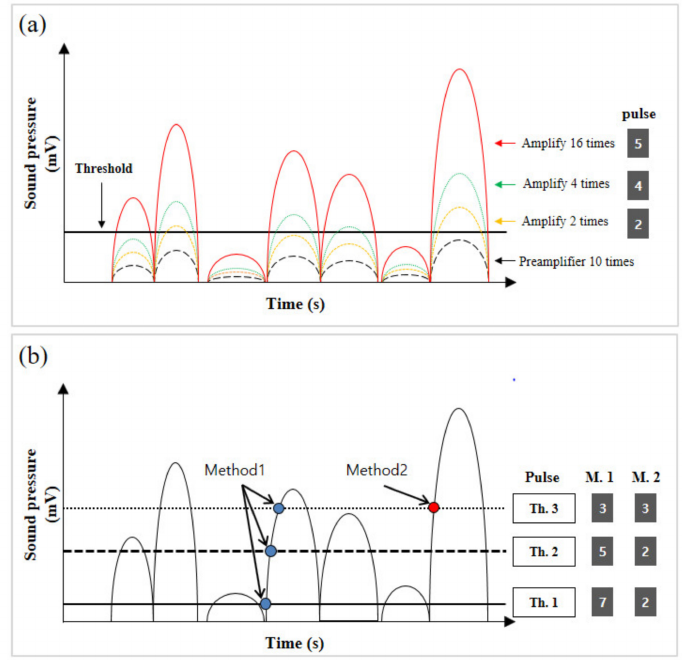
Figure 4. Acoustic signal pulse-filtering methods. ( a ) Amplification channel (Method 1); ( b ) threshold setting (Method